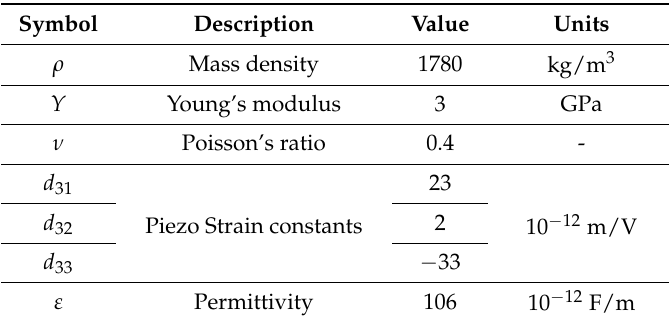
Table 1. Material properties of PVDF